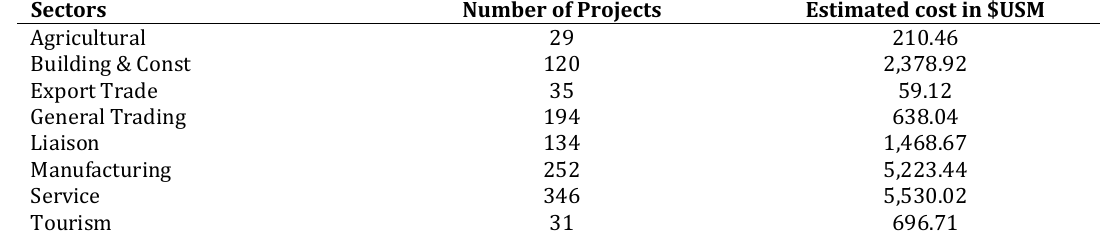
Table 4: Sectorial distribution of registered FDI projects and their cost from 2013 to 2017